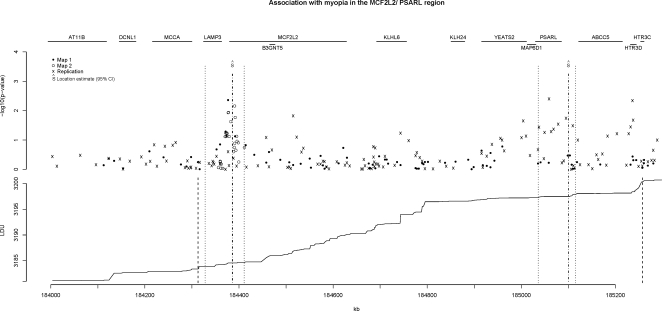
Association with myopia in the MCF2L2/PSARL gene region.Legend notes from Figure 3 apply. In this figure, two different location estimates (Ŝkb) and confidence intervals are obtained. One is for the discovery Map 2 data (MCF2L2 region, to the left of the graph) and the other the replication Hap300 data (PSARL region, to the right of the graph). The additional outer vertical dotted lines in the lower LDU graph represent the lower and upper limits of the analytical LDU window used to model the discovery and replication datasets. See Figure S3 for pair-wise LD plot of region.